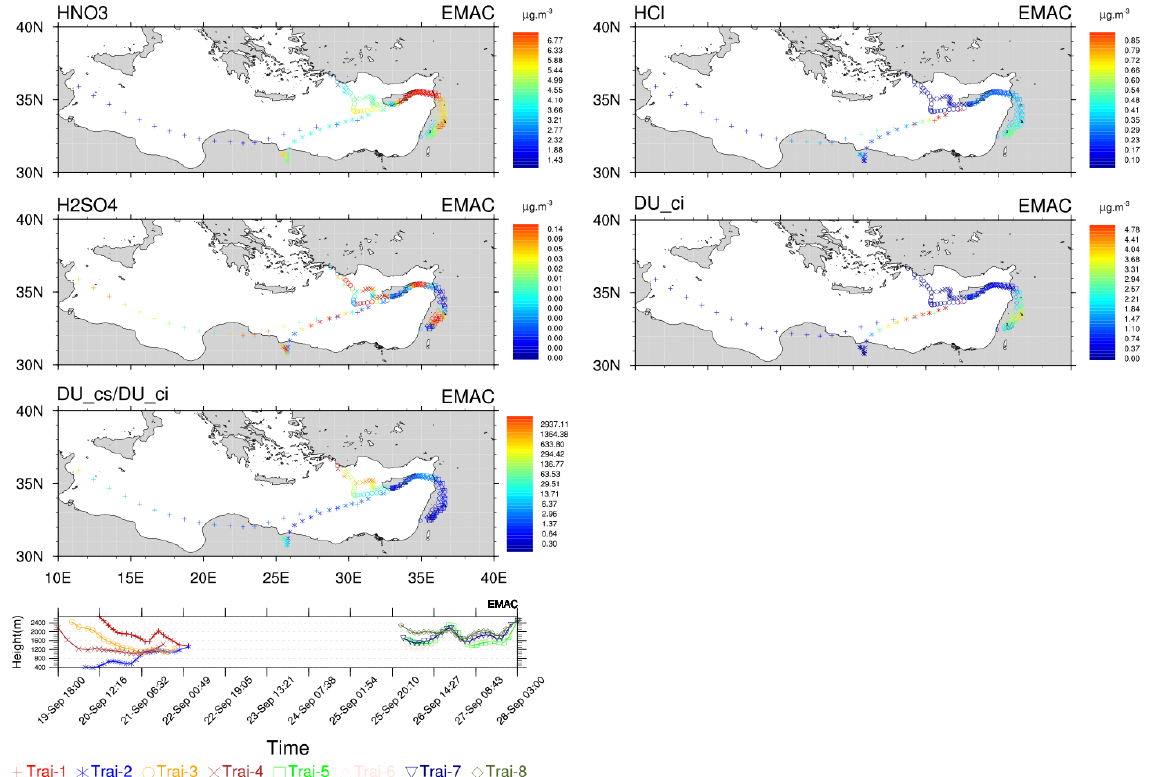
Figure 15. Sampled model concentrations for both dust outflow events; HNO 3 , H 2 SO 4 , HCl, insoluble (pristine) dust fraction (DU_ci) and the aged dust proxy, ADP